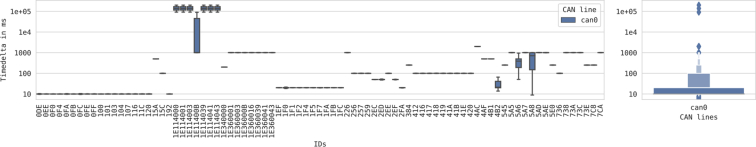
Interarrival frames times for vehicle Alfa Romeo Giulia (C-1). Values are in logarithmic scale.